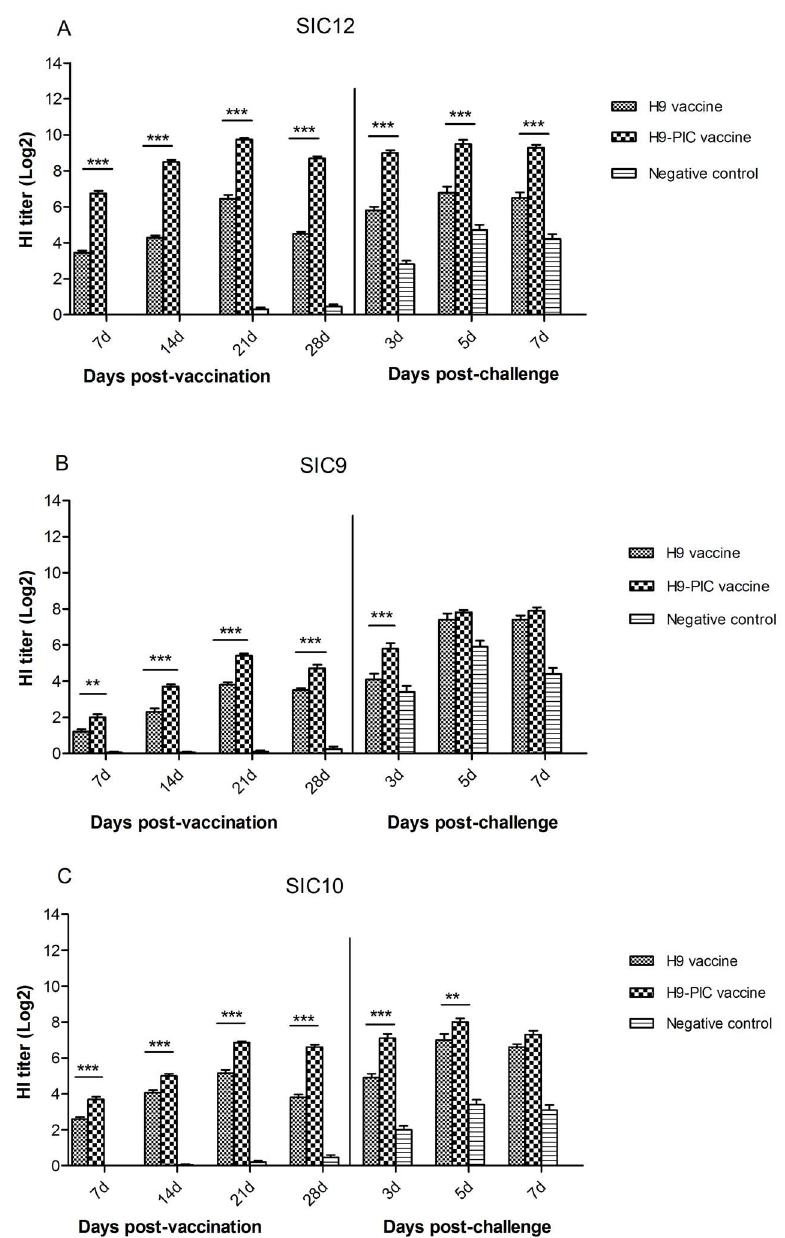
Fig 1. Serum hemagglutination inhibition (HI) levels in vaccinated-challenged ducks. Serum samples (20 ducks per group) were collectedat 7-, 14-, 21- and 28-daypost-vaccination, and at 3-, 5- and 7-day post- challenge. Antibody titers were determined using the HI assay with 4 HA units of the SIC12/13, SIC9/13 and SIC10/13 avian influenzavirus strain, respectively. The HI titer is expressedas the log2 form.Bars indicate mean ± SEM of a representative experiment. ( * P < 0.05, ** P < 0.01, *** P < 0.001). Experimentalgroupsare as in Table